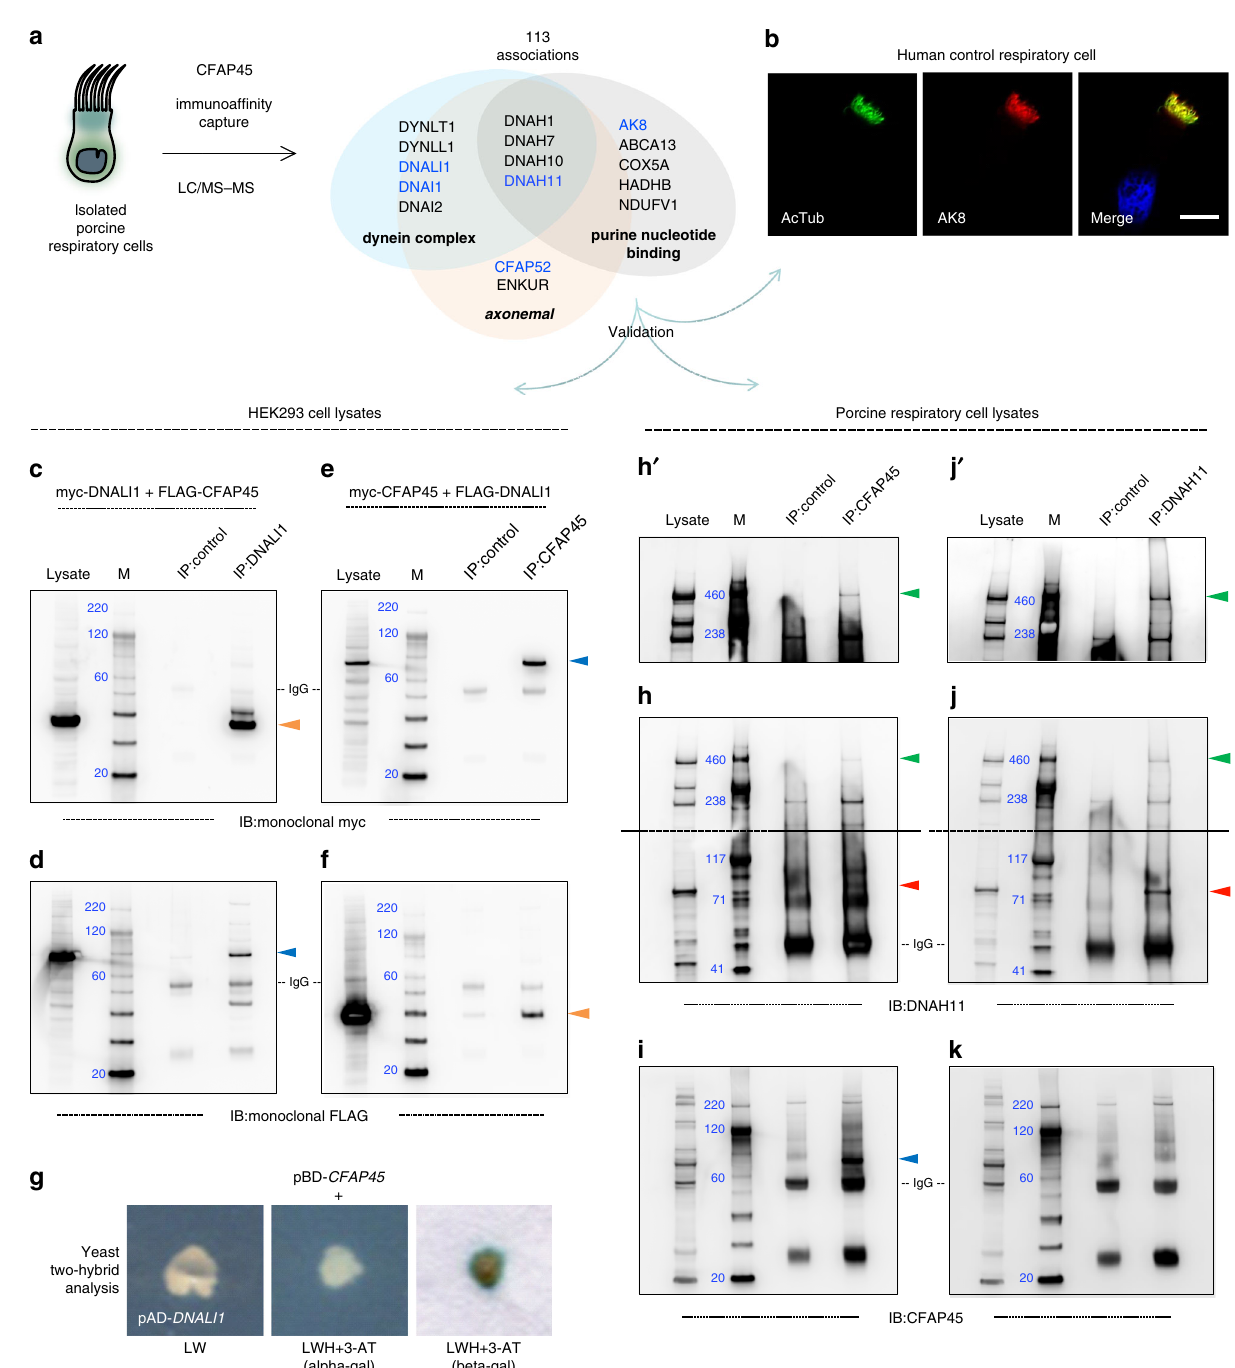
ciliated organisms 40 and have been identi fi ed as components of fl agella in Chlamydomonas reinhardtii 41 and motile cilia in Trypanosoma brucei 42 as well as upregulated transcripts of the ciliogenesis factors FOXJ1 43 and MCIDAS 44 in Xenopus laevis . These data supported a conserved ciliary function for CFAP45 and CFAP52 across eukaryotic species despite no apparent ultrastructural defects in the organization or assembly of the axoneme. IFM (Supplementary Fig. 5n), we analyzed native